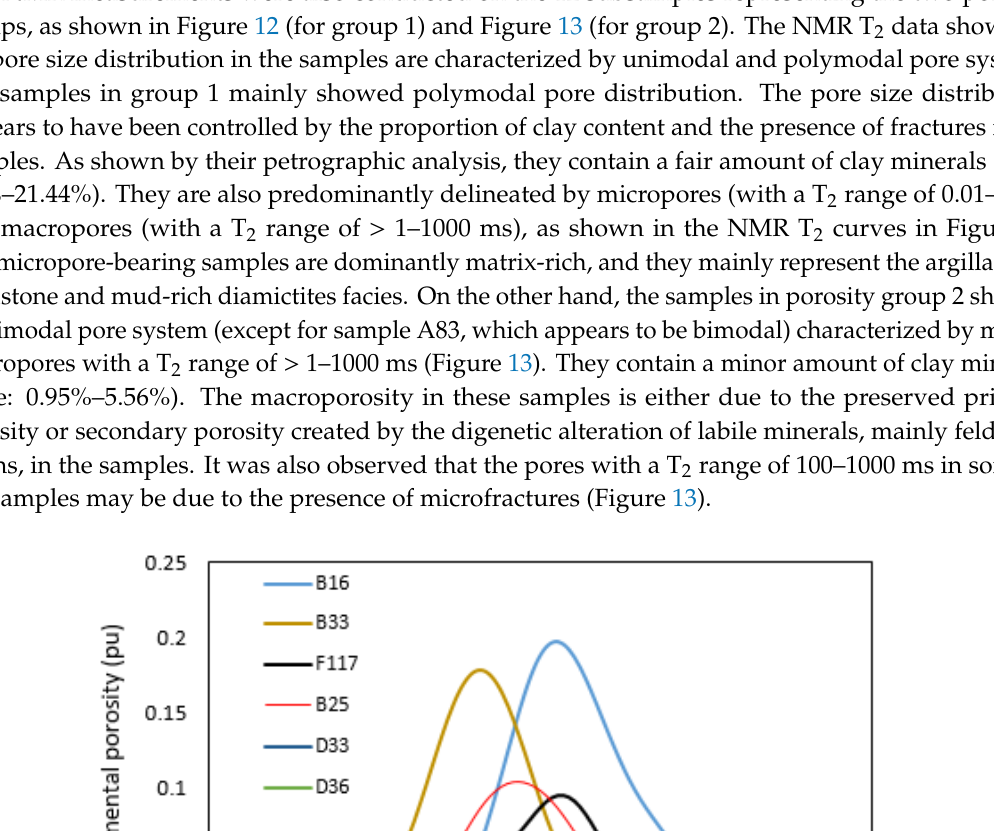
Figure 13. Distribution of NMR T 2 relaxation for subsamples in porosity group 2 (>7%).